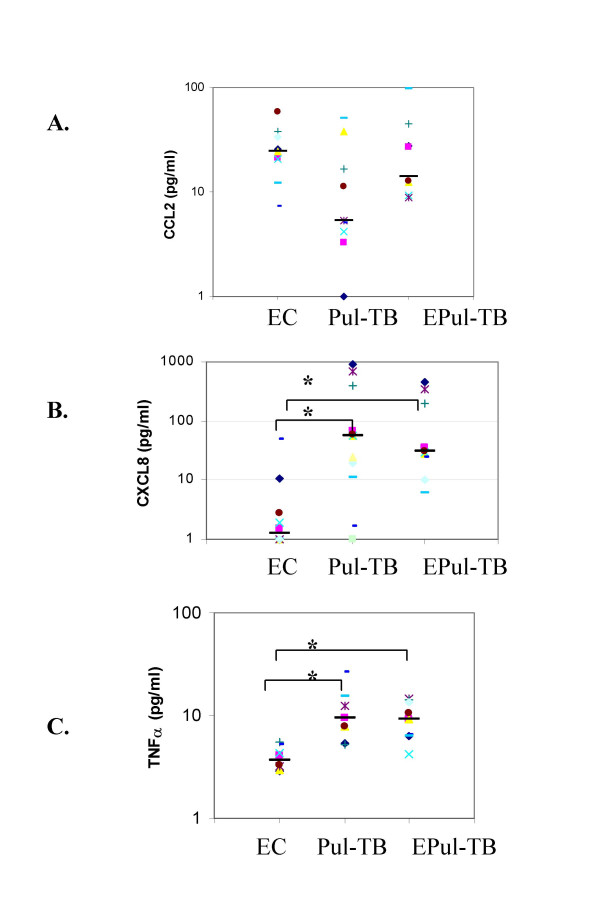
Raised CXCL8 and TNFα in sera of tuberculosis patients. Circulating levels of chemo/cytokines were determined in sera of endemic controls (EC, N = 12), pulmonary tuberculosis (Pul-TB, N = 10) and extra-pulmonary tuberculosis (EPul-TB, N = 8) patients. Values for individual subjects are shown, with the median value indicated by a horizontal line. A. CCL2, B. CXCL8 and C. TNFα. Statistical analysis was carried out using the Mann Whitney-U test with significant differences, P < 0.05, '*'.